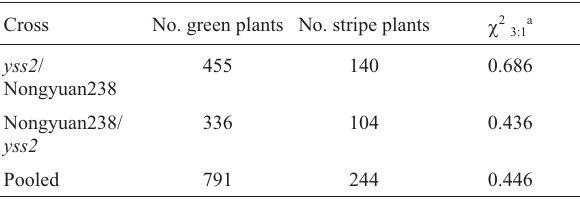
Table 2 - Segregation of green and striated seedlings in F 2 populations from two crosses. Cross No. green plants No. stripe